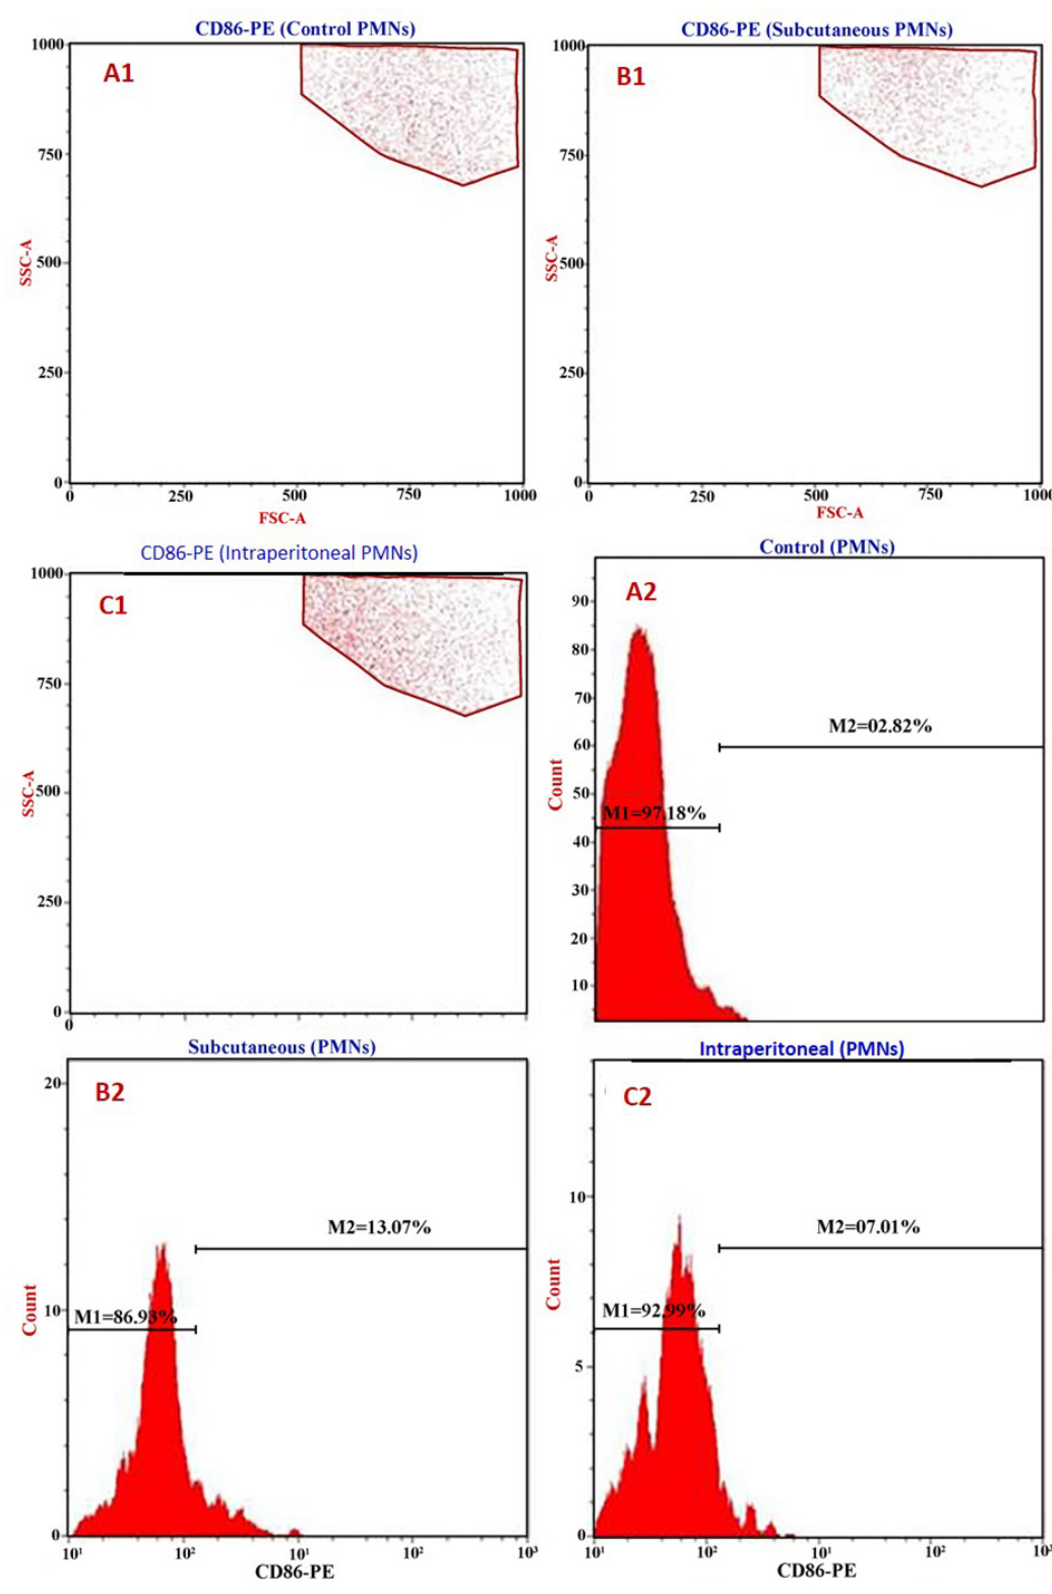
Figure 6. Representative cytoflourometry graphs of the CD86 induction in the whole blood PMNs. (A1, A2) Unstimulated PMNs (control). (B1, B2) Subcutaneous SAV-stimulated PMNs. (C1, C2) Intraperitoneal SAV-stimulated